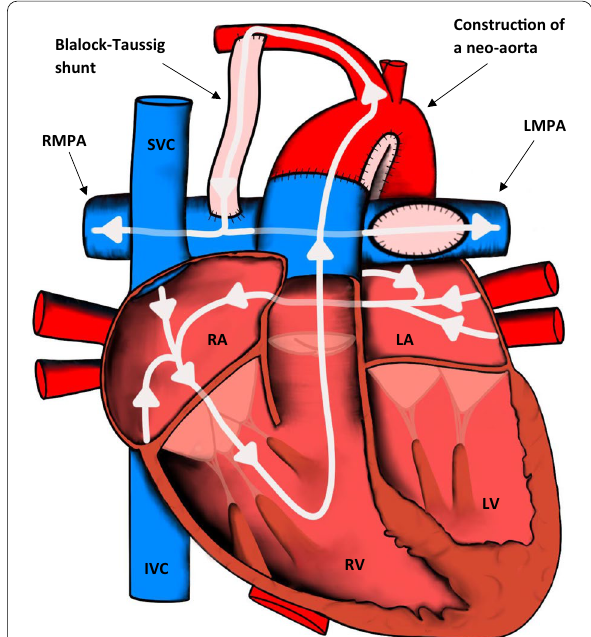
Fig. 5 Appearances of the heart after the Norwood procedure (Stage 1), which involves construction of a neo-aorta, atrial septectomy, addition of a modified Blalock–Taussig shunt, and ligation of the ductus arteriosus. IVC: inferior vena cava; LA: left atrium; LV: left ventricle; LMPA: left main pulmonary artery; RMPA: right main pulmonary artery; RA: right atrium; RV: right ventricle; SVC: superior vena